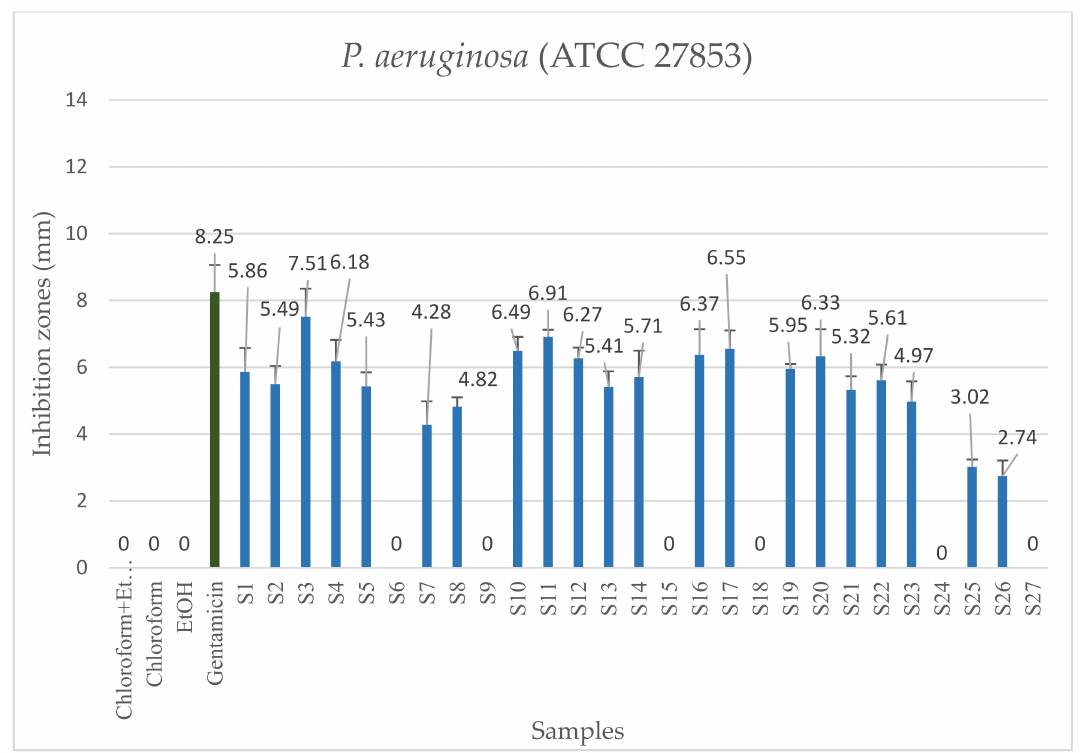
Figure 2. Antibacterial activity of each clary sage extracts and gentamicin as positive control on P. aeruginosa . The numbering of the samples is the same as that shown in Table 1.